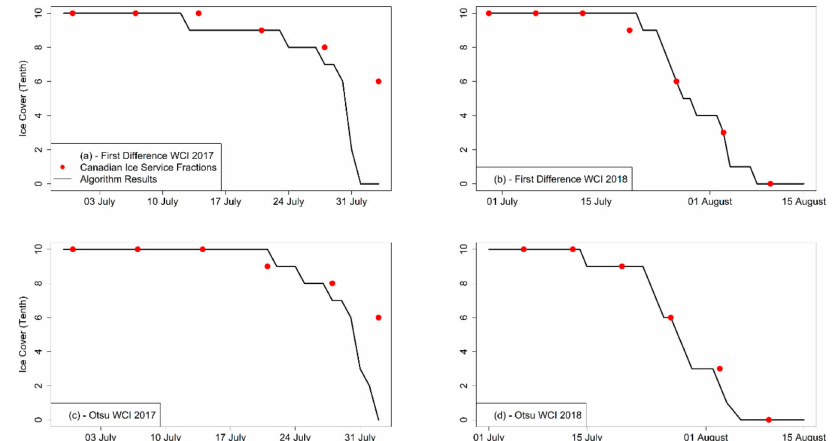
Figure 16. Comparison of ice cover fractions from the Canadian Ice Service (CIS) to those estimated from the first di ff erence and Otsu methods during the break-up period. ( a , b ) show the lake ice cover fraction estimated by the first di ff erence method compared to the CIS estimates. ( c , d ) show the lake ice cover fraction estimated by the Otsu method compared to the CIS estimates.